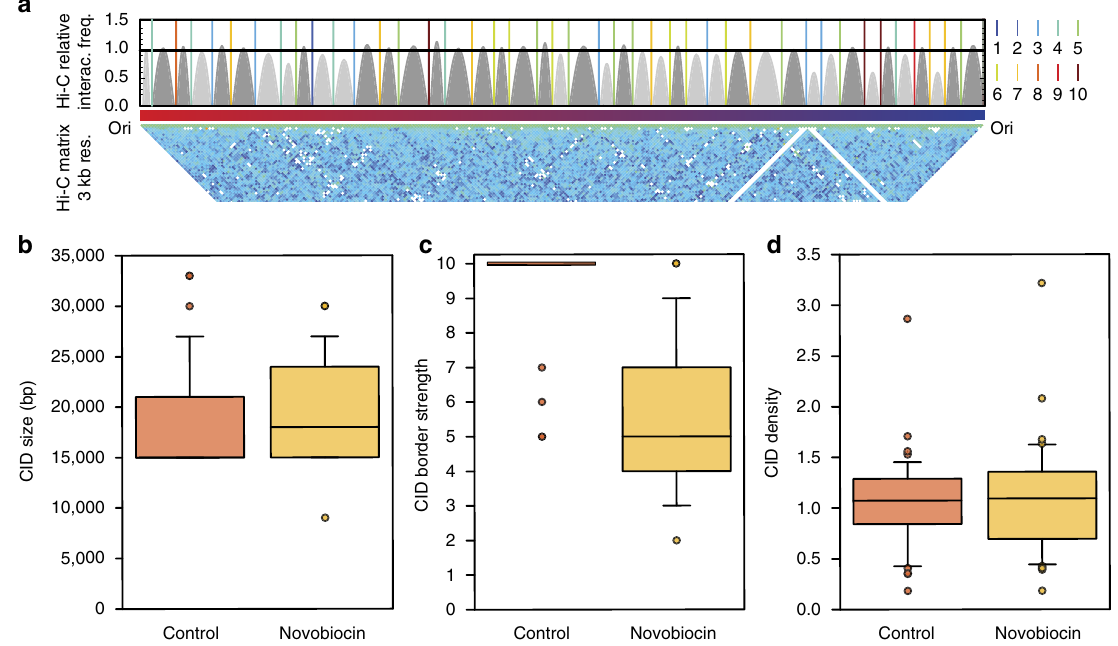
Figure 5 | Inhibiting supercoiling decreases the sharpness of domain borders. ( a ) Same as Fig. 4a, but with Hi-C HpaII Novobiocin-treated contact map at 3kb resolution. ( b – d ) Boxplot distributions and median values of CID size, border strength and density distribution in wild-type (orange) and Novobiocin- treated (yellow) cells. The CID density is computed as the sum of all the Hi-C interactions in a domain divided by the expected number of interactions, where the expected number of interactions is computed as an average for each genomic distance 71 . The units of the CID density are thus interactions normalized by the genomic distance.